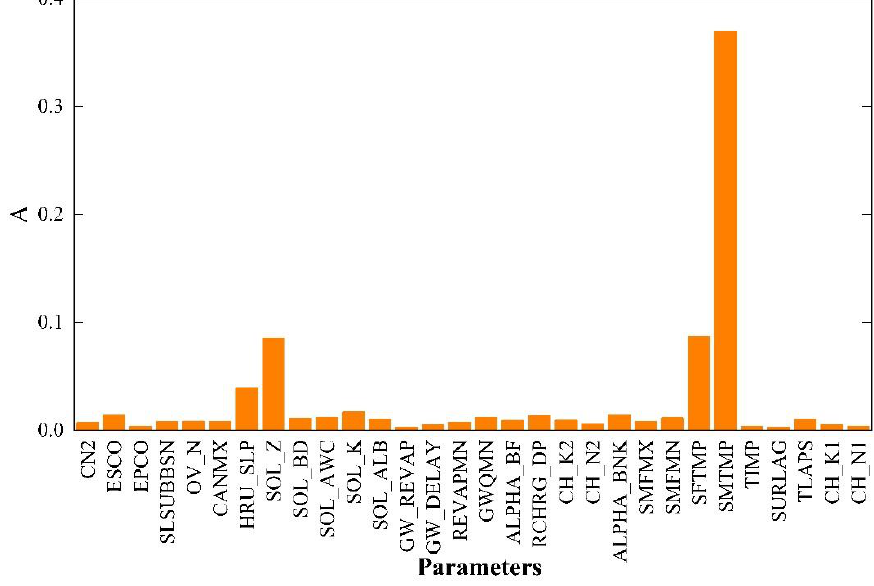
Figure 10. Amplitude ( 𝐴 ) of each parameter of